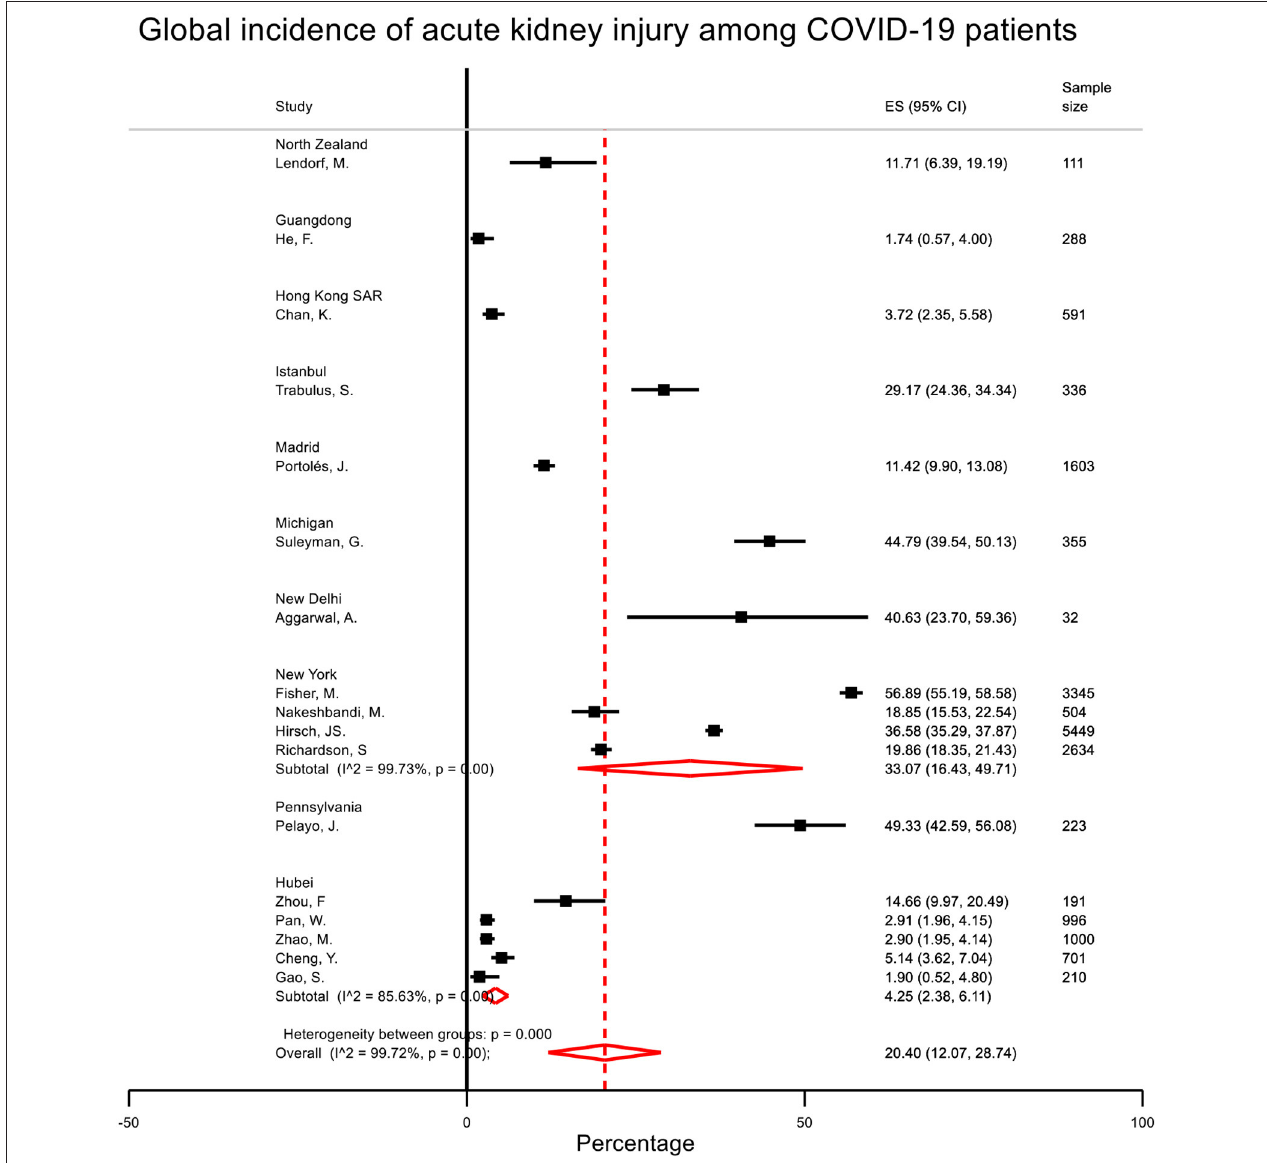
FIGURE 2 | Global incidence of acute kidney injury among COVID-19 patients with no history of renal replacement therapy. The pooled incidence of acute kidney injury (17 studies, n = 18,569) was 20.40% with considerable heterogeneity across provinces/states.